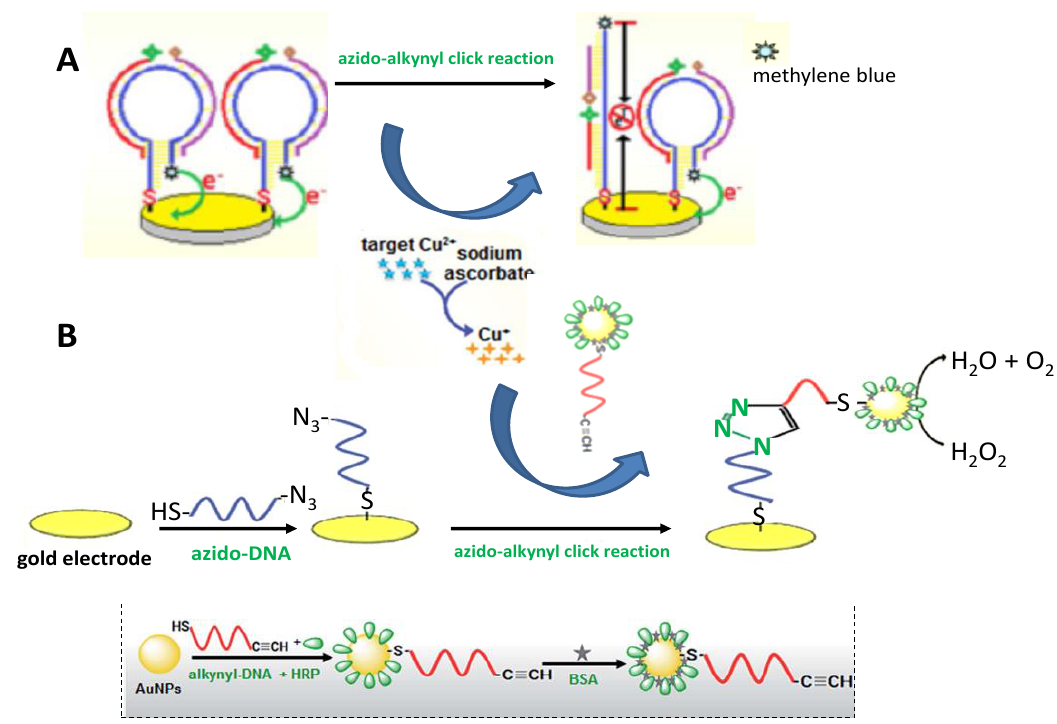
Figure 10. Schematic illustrations of the sensing strategies reported for copper ion detection by target-induced click conjugation of two oligonucleotides labeled with azides and alkynes using methylene blue-functionalized hairpin DNA as the template ( A ) or HRP as indicator and AuNPs as enhancer ( B ). Inset: preparation of alkynyl-DNA/HRP/BSA/AuNPs. Reprinted from [64] ( A ) and [74] ( B ) with permission.